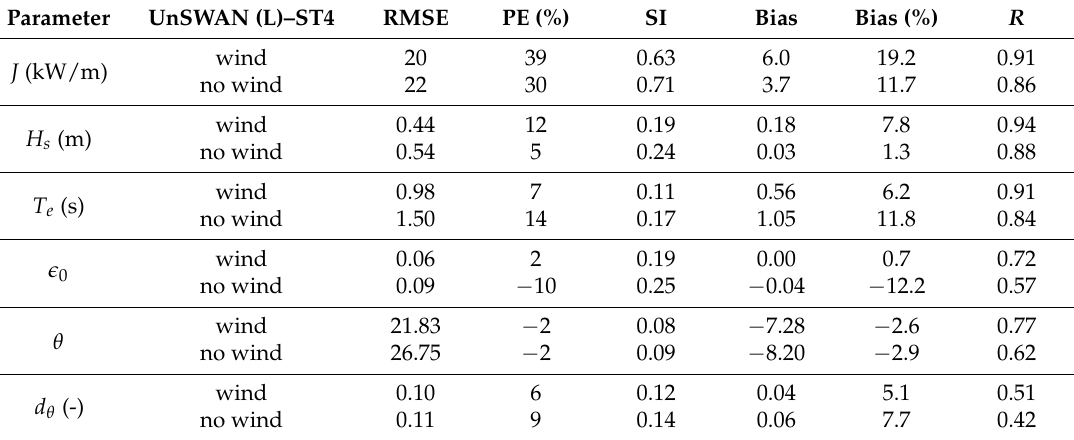
Table 3. Performance matrix for UnSWAN (L), considering wind effects using the ST4 physics package. Parameter UnSWAN (L)–ST4 RMSE PE (%) SI